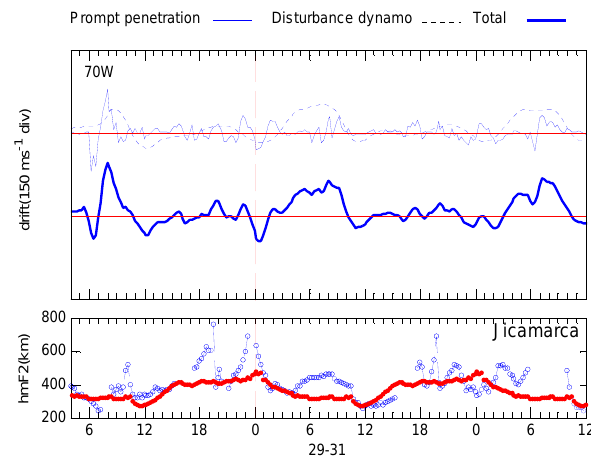
Fig. 9. Up panel displays storm-time upward drift derived from Fejer and Scherliess’s (1997) mode for the longitude 70°W. The broken, thin solid and thick solid line each represents the disturbance dynamo electric field drift, prompt penetration electric field drift and the composite drift of these two. Bottom panel shows the storm-time vs quiet hmF2 variations at Jicamarca.